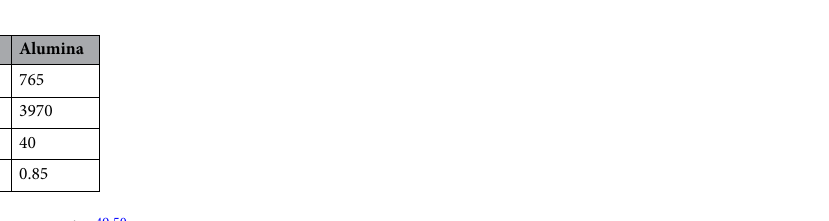
Table 3. Nanoparticle properties 49,50 .